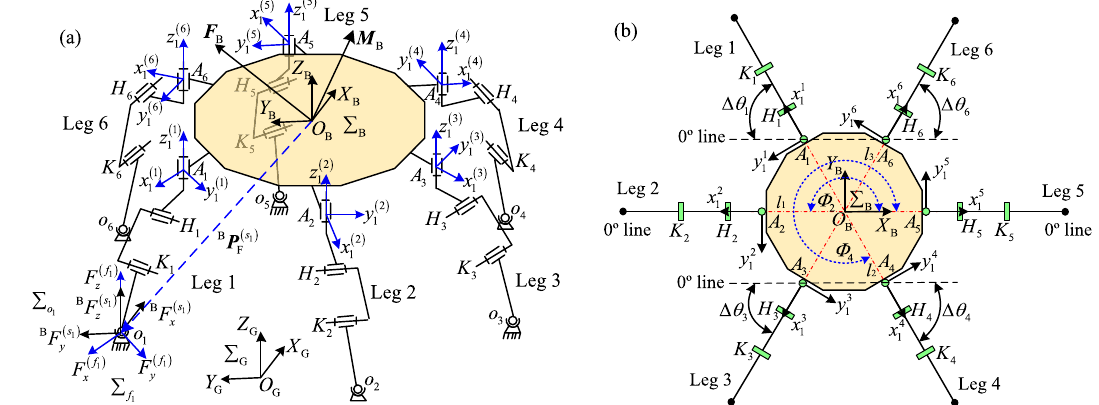
Figure 2 Mechanism and top view of large-load-ratio six-legged robot [10, 26, 27]: a Mechanism of robot, b top view of